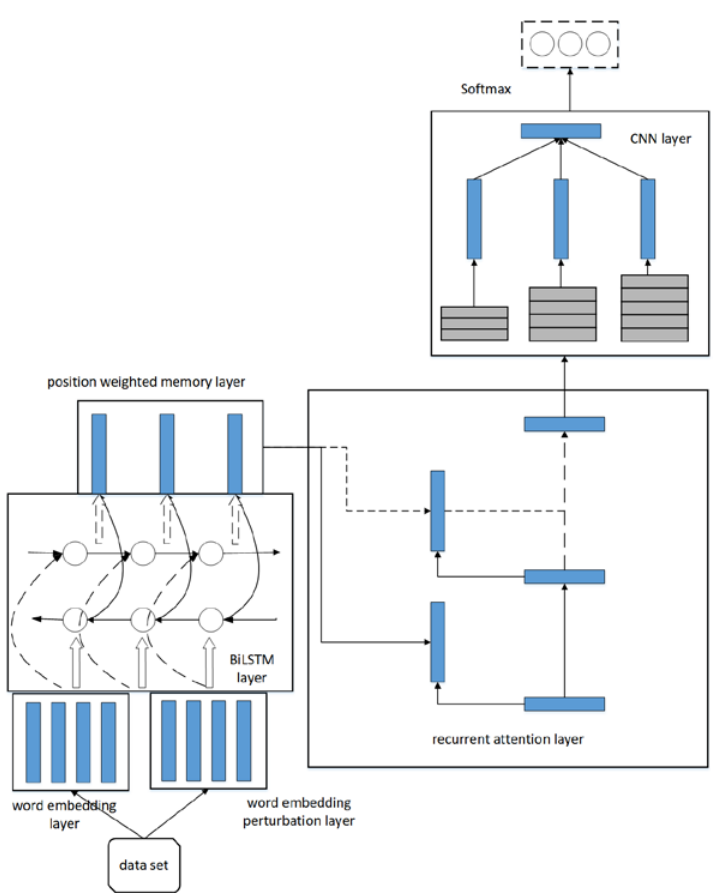
Fig. 1. Overall model